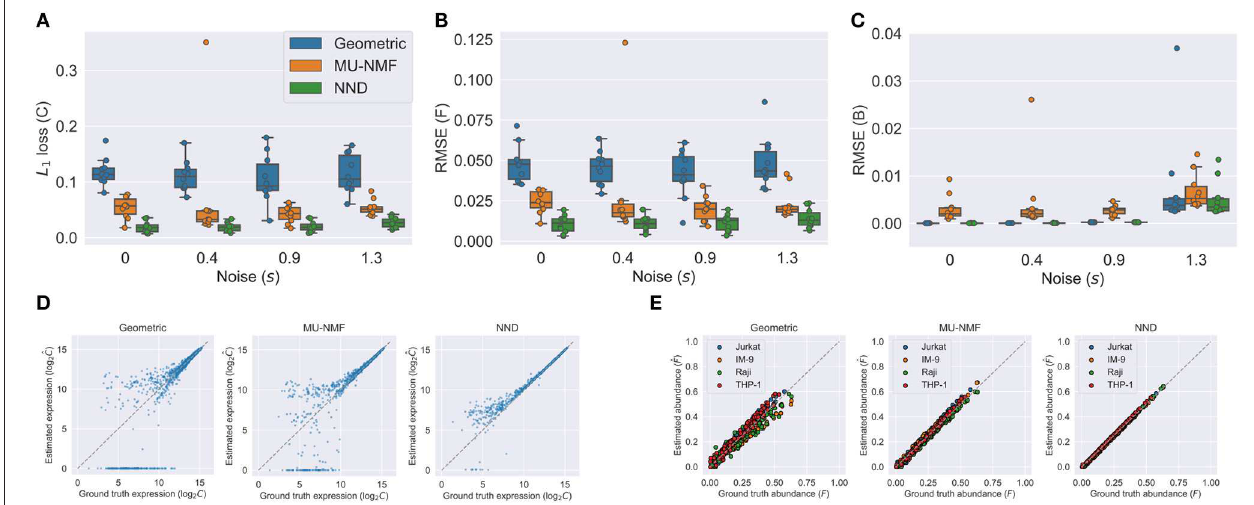
FIGURE 3 | Comparison of NND and other algorithms on the semi-simulated GSE11103 dataset shows the better accuracy and robustness of NND algorithm. (A–C) Accuracies in estimated C , F , and B with three different algorithms. We tested four noise levels and repeated the experiments for ten replicates. (D) Estimated ˆ C and ground truth C using three different algorithms with noise level s of 1.3. (E) Estimated ˆ F and ground truth F using three algorithms with noise level s of